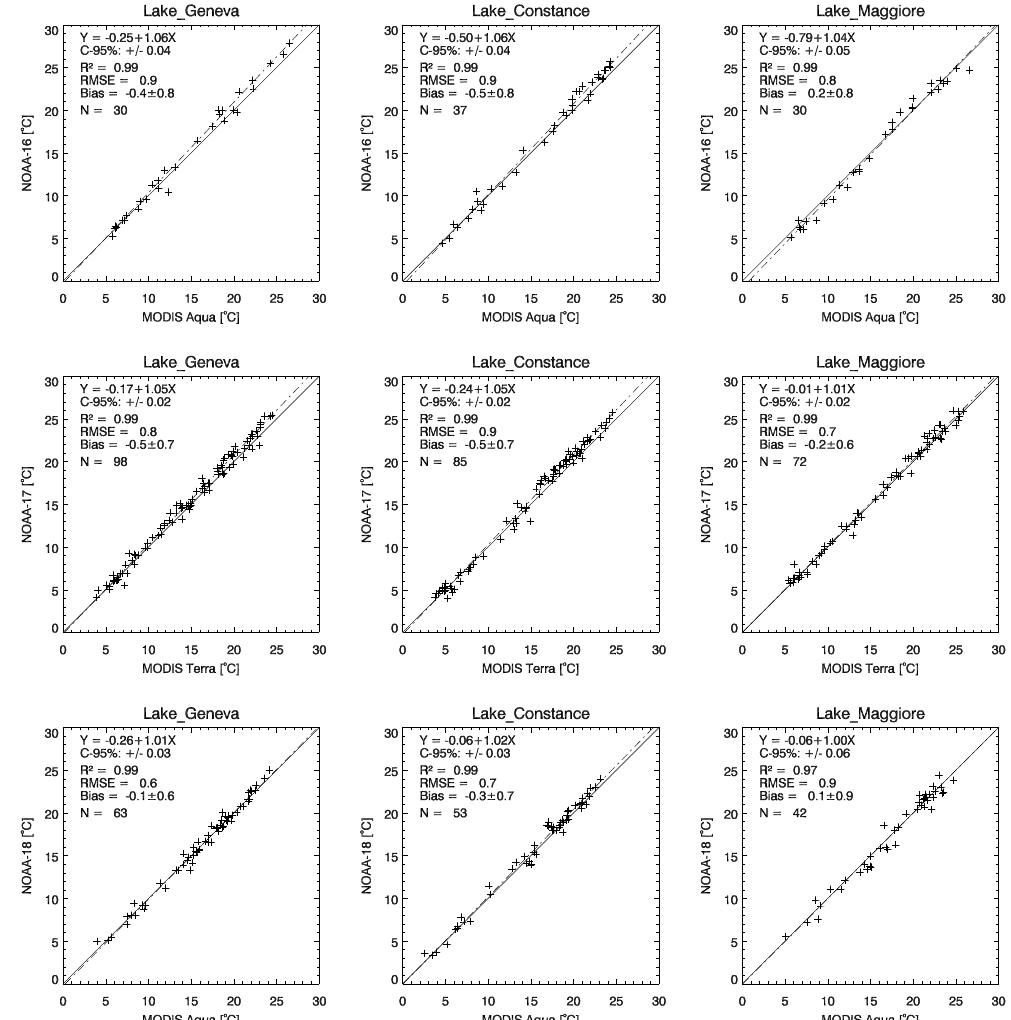
Figure 7. Scatter plots with the comparison between the MODIS Terra and Aqua Land Surface Temperature and Emissivity data set and the AVHRR LSWT-retrieval based on RTTOV-10 (RT-lswt). The upper panel shows the comparison between NOAA-16 and MODIS Aqua, the central panel shows NOAA-17 and MODIS Terra, the lower panel shows NOAA-18 and MODIS Aqua. Statistical results include the linear regression equation (dash-dotted); the 95% confidence interval of the regression line; the coefficient of determination as square of the correlation coefficient ( R 2 ); the root-mean-square error (RMSE); the bias as the mean temperature difference and standard deviation ( (cid:49)T ± σ (cid:49)T ) between MODIS and RT-lswt; and the number of coincident observations (within ± 15min). The position of the lakes is shown in Table 1 and Fig. 1.